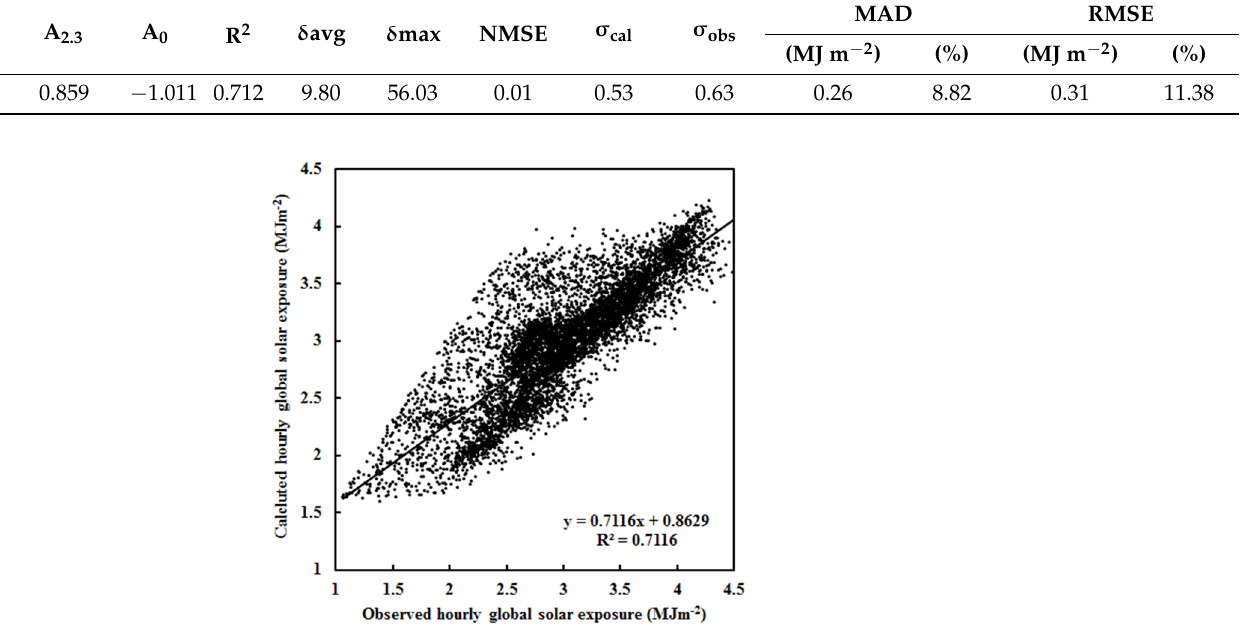
Figure 1. Scatter plot of calculated versus observed hourly global solar exposure under all-sky conditions at Qomolangma (n = 7020). Table 1. The coefficients and constants (MJ m − 2 ), coefficient of determination (R 2 ), average and maximum of the absolute relative bias ( δ avg, δ max (%)), NMSE (MJ m − 2 ), and standard deviations of calculated and observed global solar exposure ( σ cal and σ obs , respectively, MJ m − 2 ), along with the mean bias errors (MAD, MJ m − 2 and %) and the root mean square error (RMSE, MJ m − 2 and %) (n = 7020).